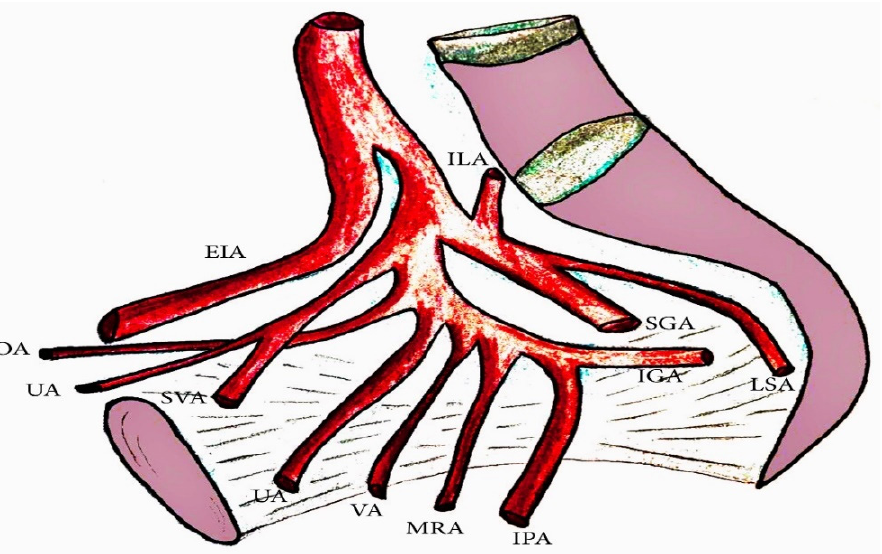
Figure 7. The internal iliac artery (IIA) branches. OA—obturator artery, UA—obliterated